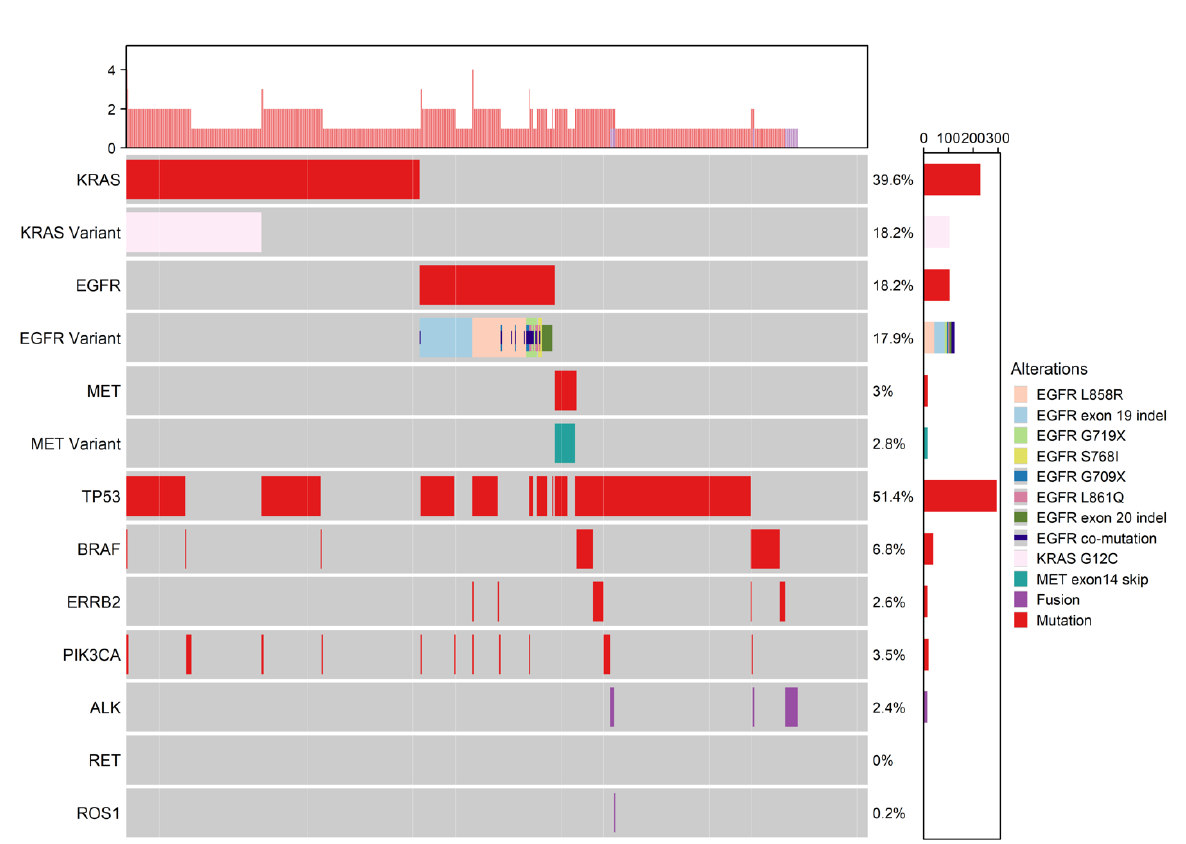
Figure 2. Oncoprint of the late-stage NSCLC cohort genomic alterations. This oncoprint depicts genetic alterations identified by the DNA-based hybrid-capture multiplex NGS assay (“oncopanel”) from the Cancer Genetics & Genomic Laboratory (CGL) at BC Cancer Vancouver Centre. ALK, RET, and ROS1 were detected with immunohistochemistry in this cohort. On the right, the alteration frequency per gene is reported, with the corresponding gene labelled on the left side. The barplots beside the gene labels report the alteration counts. The topmost bar represents the mutation and fusion count per sample. Table 5. Comparison of outcomes between early and late-stage among all and matched